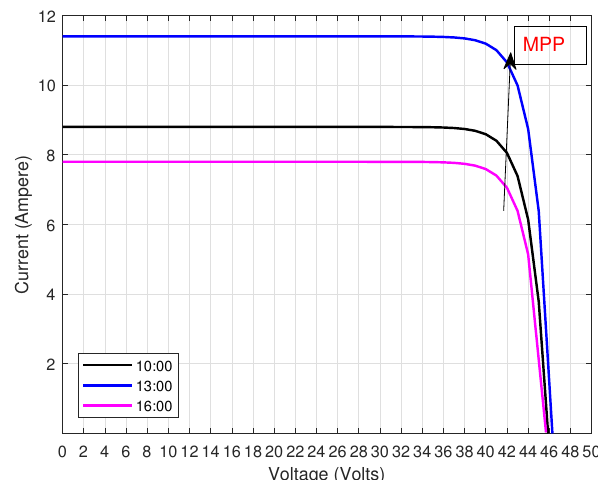
Figure 4. Solar cell I-V